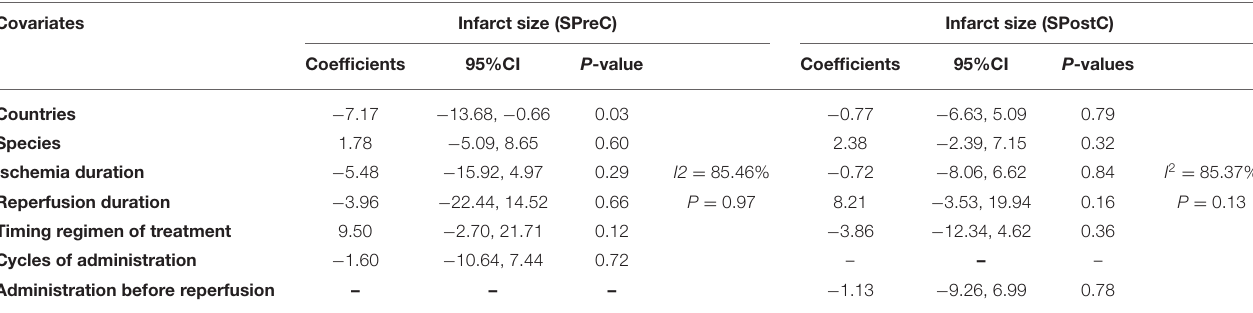
TABLE 2 | The univariate meta-regression analyses to determine potential sources of heterogeneity for infarct size sparing in the included studies of SPreC and SPostC. Covariates Infarct size